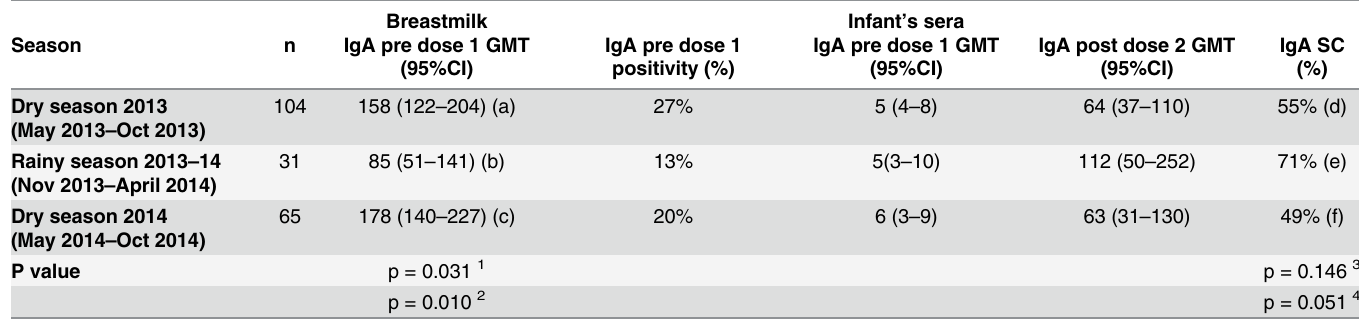
Table 3. Rotavirus-specific IgA in Breastmilk and sera, and RV-IgA serconversion (SC), by seasons (N =